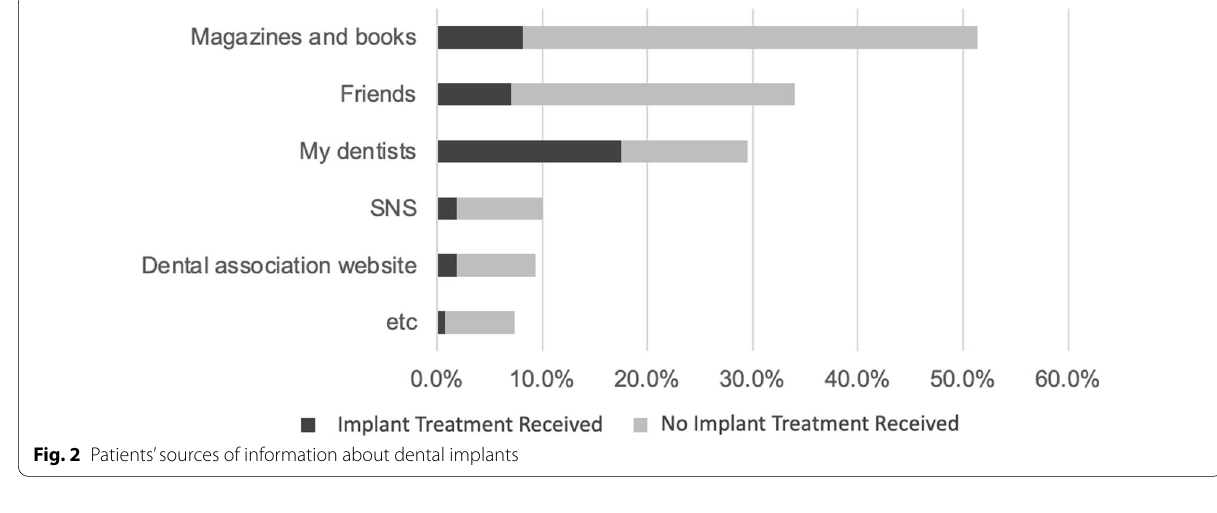
Fig. 2 Patients’ sources of information about dental implants